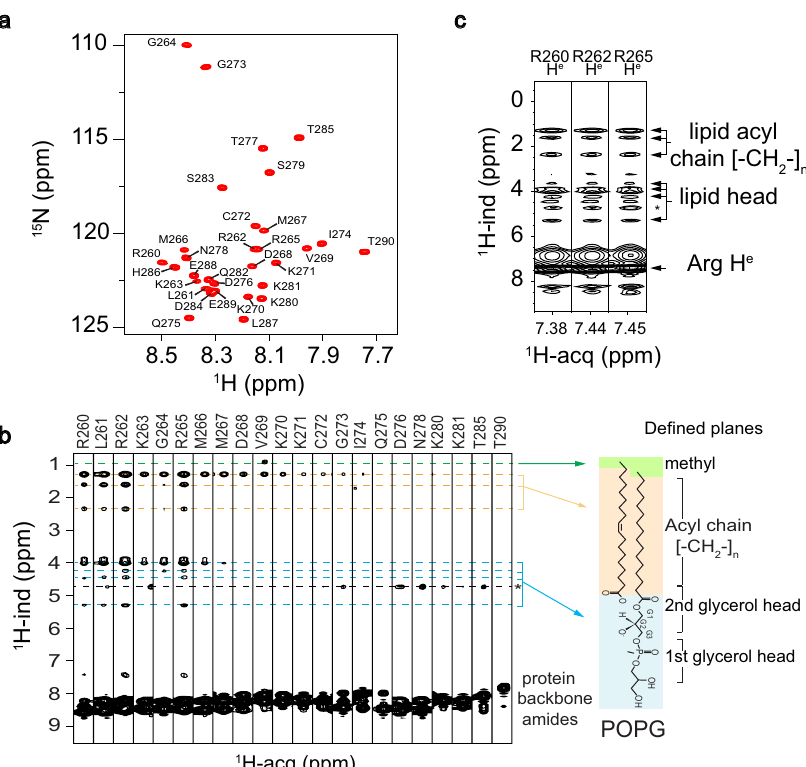
Fig. 2 The NMR characterization of membrane-bound CD 260-290 . a 1 H- 15 N TROSY-HSQC spectrum of CD 260-290 in POPG/DH 6 PC bicelles with backbone resonances assigned. The spectrum was recorded at 1 H frequency of 600 MHz using [ 15 N, 2 H]-labeled protein. b Lipid NOEs from CD 260-290 in POPG/ DH 6 PC bicelles. Strips from 3D 15 N-edited NOESY-TROSY-HSQC ( τ NOE = 200 ms) spectra recorded using 0.8 mM [ 15 N, 2 H]-labeled CD 260-290 in the bicelles with protonated POPG and deuterated DH 6 PC show the NOEs exclusively between backbone amide protons of CD 260-290 and methyl protons or methylene protons of lipid acyl chains of POPG, and the NOEs between backbone amide protons of CD 260-290 and glycerol protons of lipid head groups and water protons (*), mostly for the residues in the N-terminal half of the protein. The spectrum was recorded at 1 H frequency of 900 MHz. c Strips from the same experiment mentioned above showed the NOEs from the side chains of three arginine residues to the lipid acyl chains and headgroups of